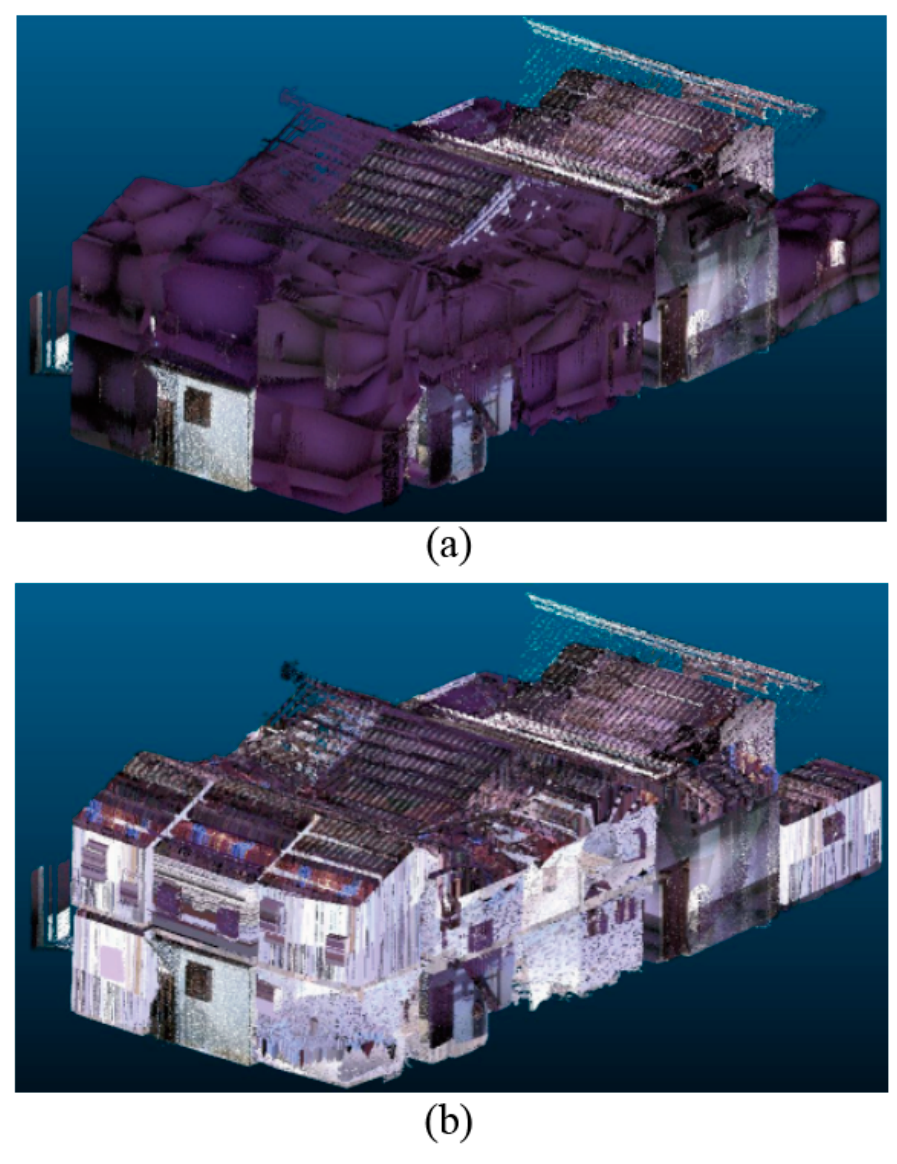
Figure 11. Entire point clouds of the Zou Lu House: ( a ) the original registered point cloud; ( b ) registered point cloud after the proposed colorization method is applied.